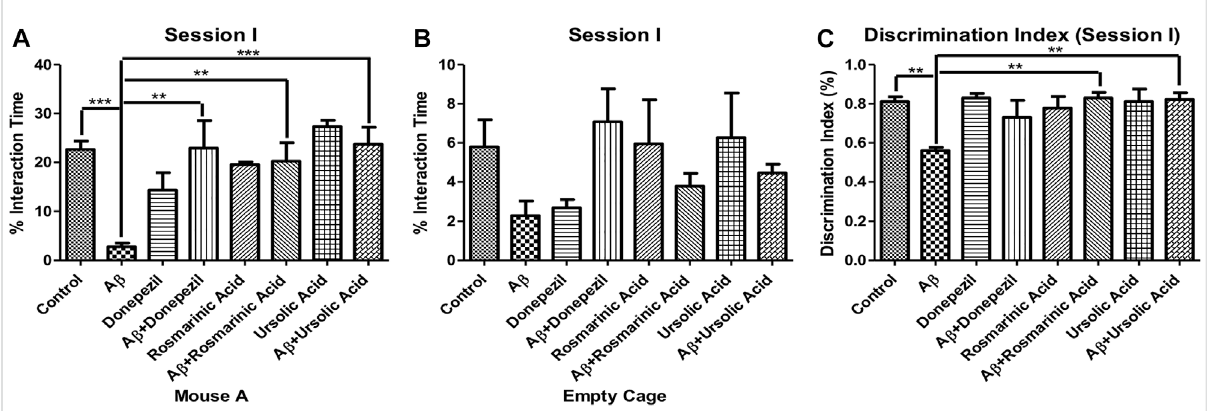
FIGURE 1 Effect of RA and UA on Social Af fi liation behavior. (A) Interaction time with the Mouse A. (B) Interaction time with the empty cage. (C) Discrimination index during session (I). Signi fi cance was analyzed by one-way ANOVA followed by Bonferroni comparison test (mean ± SEM) using